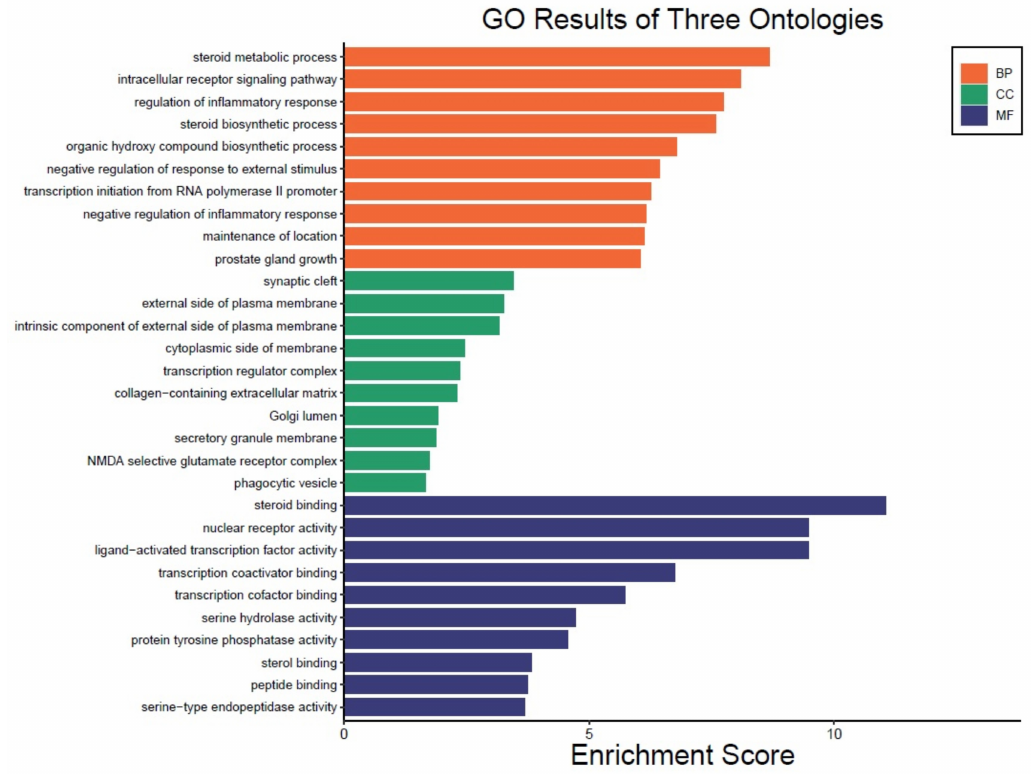
Figure 3. GO enrichment analysis of target genes. Biological Process (BP), Cellular Component (CC), Molecular Function (MF). Height of bar represents number of target